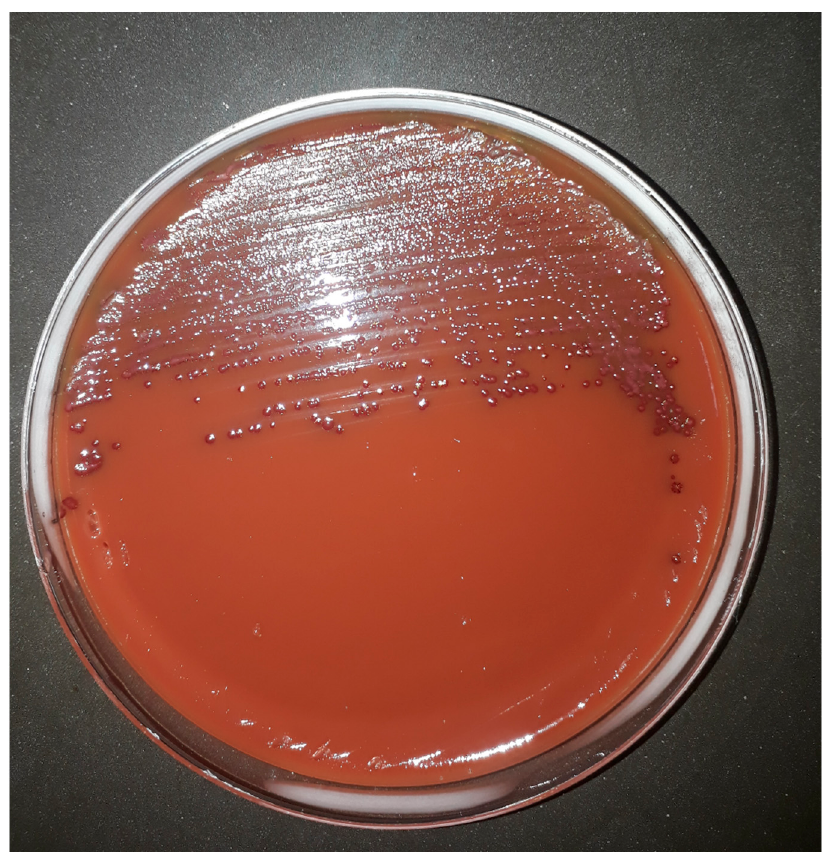
Figure 1. Strain C. jejuni (ATCC 33560 T ) was streaked on CAMPYAIR and incubated at 42 °C under aerobic conditions for 48 h. Table 2. Quantitative growth (CFU/mL) of strains C. jejuni (ATCC 33560 T ) and C. coli (DSM 4689 T ) on BA incubated under microaerobic conditions and on CAMPYAIR incubated under aerobic conditions. Bacteria were enumerated using the Miles and Misra method.